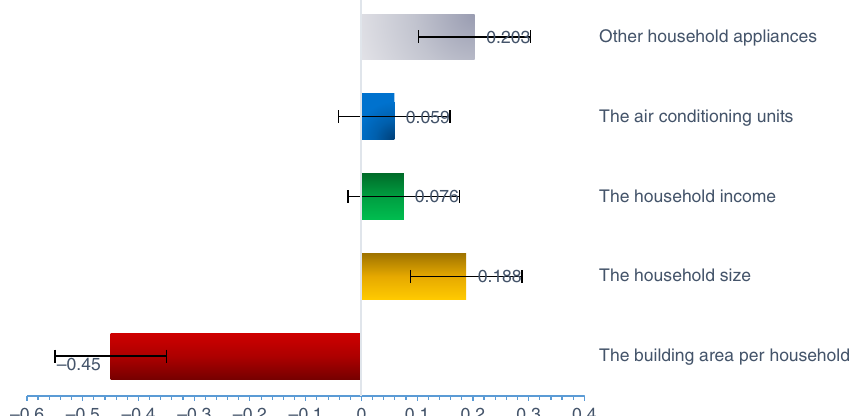
Fig. 1 The in fl uence coef fi cients for the variables. The in fl uence coef fi cients for household size, household income, number of air conditioning units and other household appliances on the URBEC per square meter are shown in different colors. Error bars are added in excel to donate S.D.